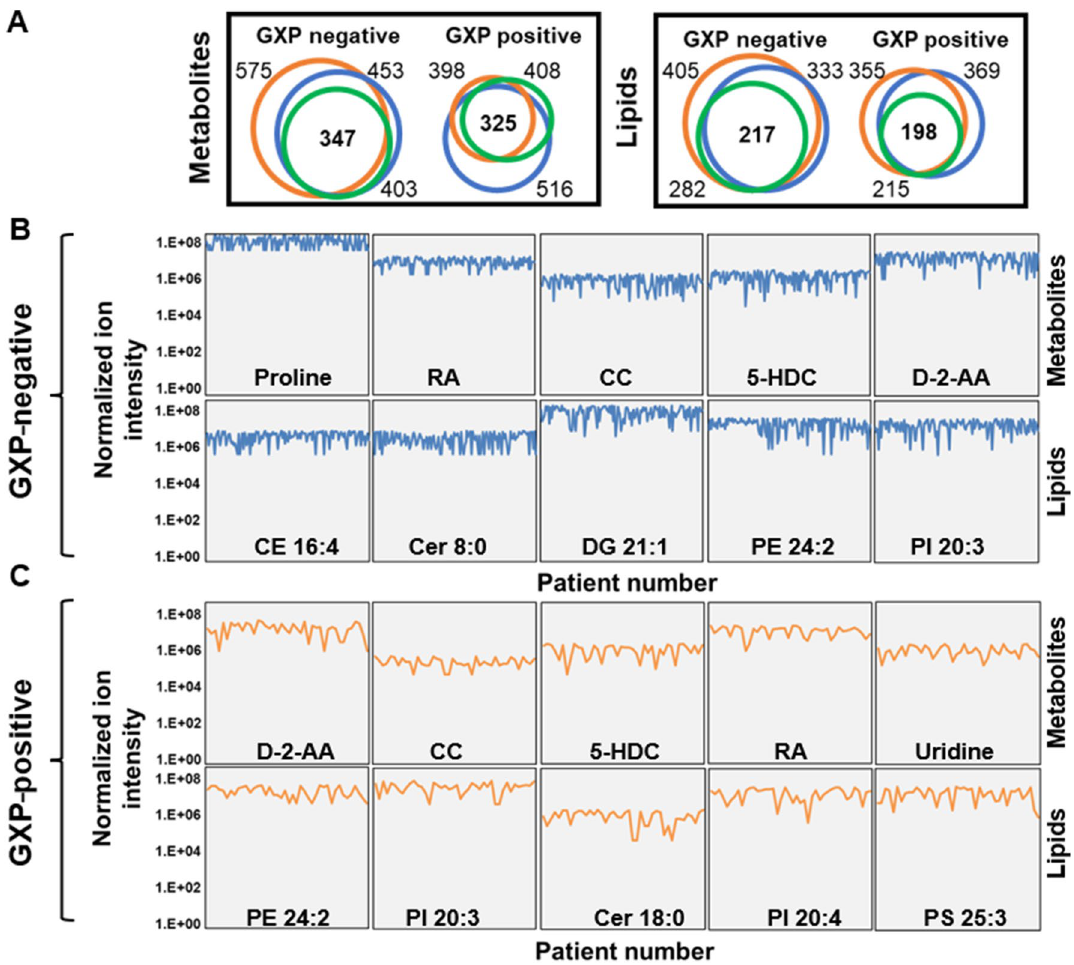
Figure 5. Identification of definitive features in GXP-negative and GXP-positive groups. ( A ) Numbers of metabolites and lipids identified in each study group at each visit. ( B ) The five most abundant metabolites and lipids identified in ( B ) GXP-negative and ( C ) GXP-positive study participants. Blue, green, and orange circles indicate the numbers of identified molecules at each